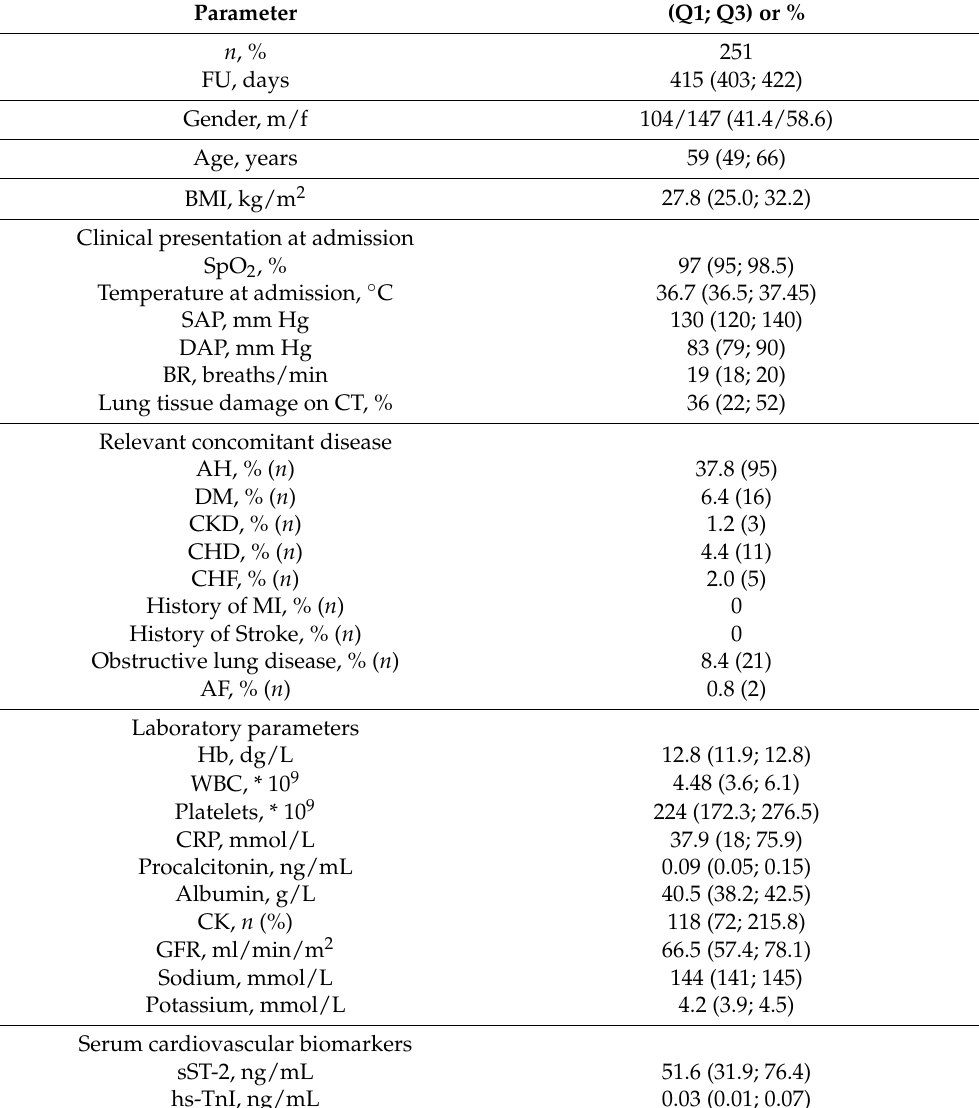
Table 1. Baseline